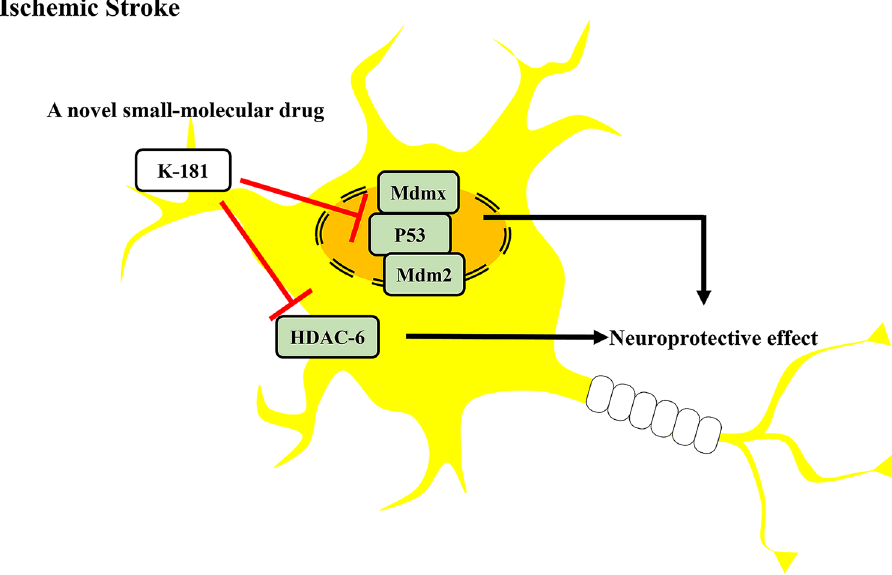
Figure 7. K-181 exerts neuroprotective effects by modifying the interactions between Mdmx and p53 and selectively inhibiting HDAC6